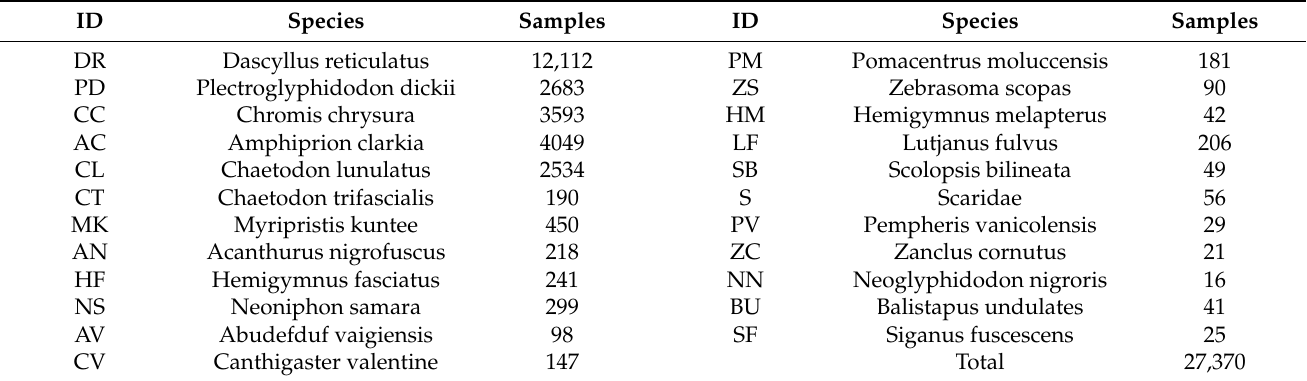
Table 1. The fish species distribution in the FRGT dataset.